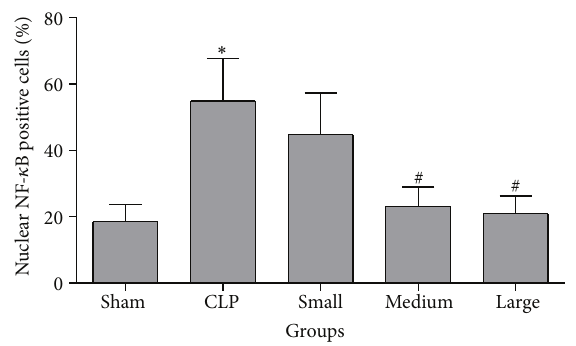
Figure 8: Effect of dexmedetomidine on NF- 𝜅 B p-65 activation in lung tissues of septic rats by immunohistochemistry staining. Sham: sham operation group; CLP: cecal ligation and punc- ture operation group; Small: 5 𝜇 g/kg dexmedetomidine treatment group;Medium:10 𝜇 g/kgdexmedetomidinetreatmentgroup;Large: 20 𝜇 g/kg dexmedetomidine treatment group. The degree of NF- 𝜅 B activation was indicated as percentage of nuclear NF- 𝜅 B p-65 positive cells to total alveolar epithelial cells. Data are expressed as mean ± SD, 𝑛 = 8 . ∗ 𝑃 < 0.01 , versus sham group; # 𝑃 < 0.01 , versus CLP